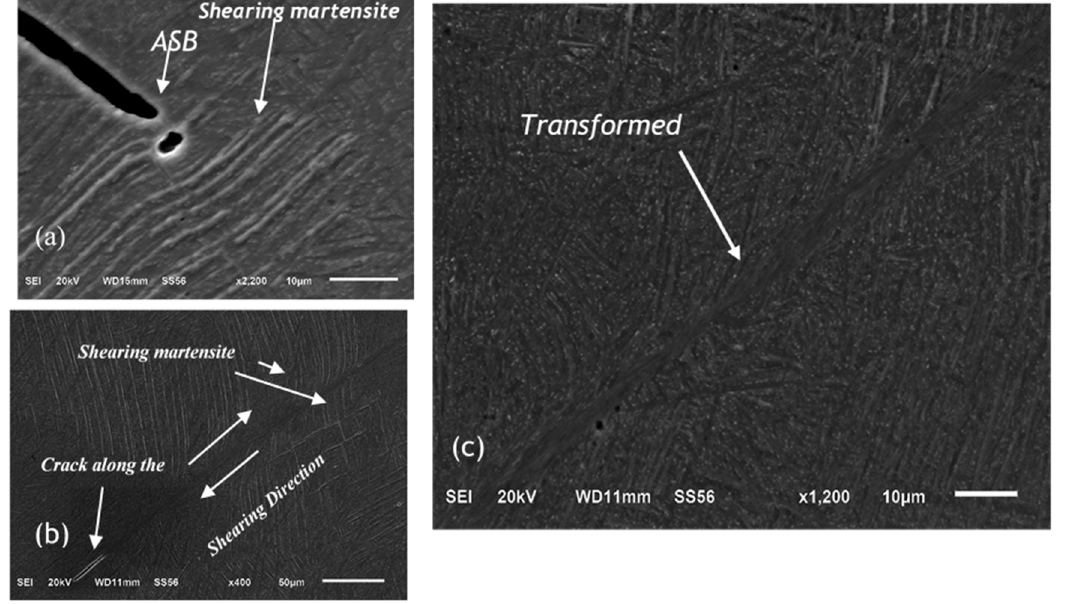
Figure 12. SEM-SEI of deformed (shearing martensite) ( a , b ) and transformed adiabatic shear bands ( b , c ) in DMLS Ti6Al4V (ELI).